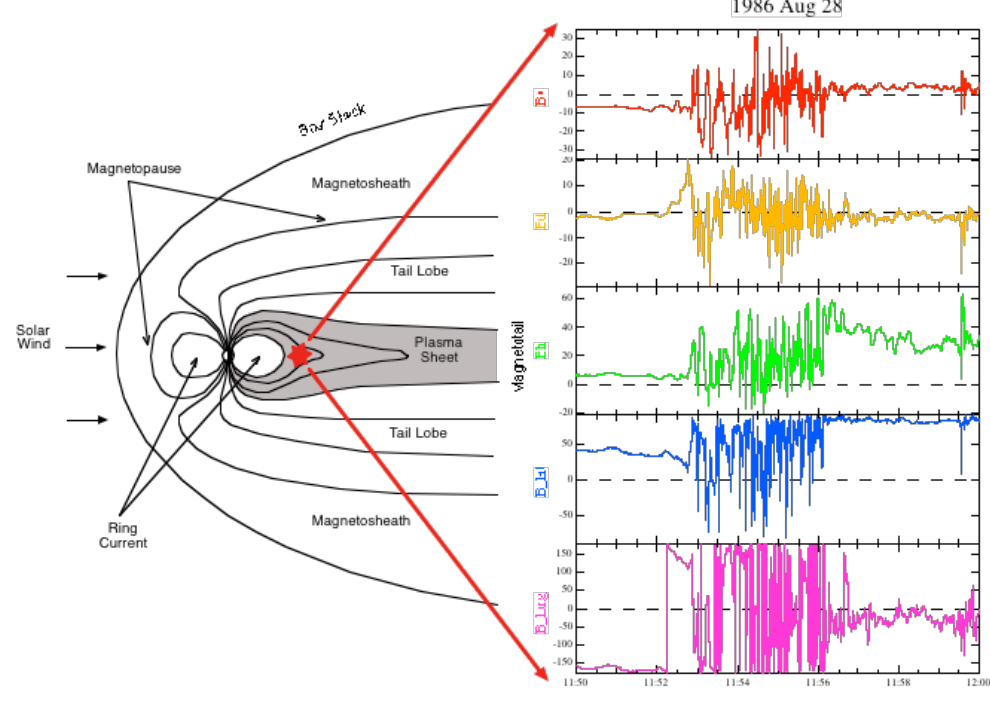
Figure 1 Fig. 1. (Left) Schematic illustration of current disruption in the near-Earth magnetotail. (Right) Observation of large magnetic fluctuations in all components, which are distinct characteristics of the current disruption phenomenon. The top three panels show the magnetic field components and the bottom two panels show the orientation angles of the magnetic field. The onset of large magnetic fluctuations preceded the ground substorm expansion onset by ∼